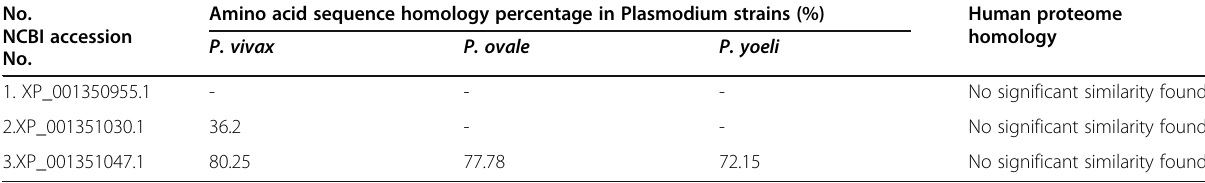
Table 2 Homology and conservation characteristics of 3 extracellular hypothetical proteins of Plasmodium